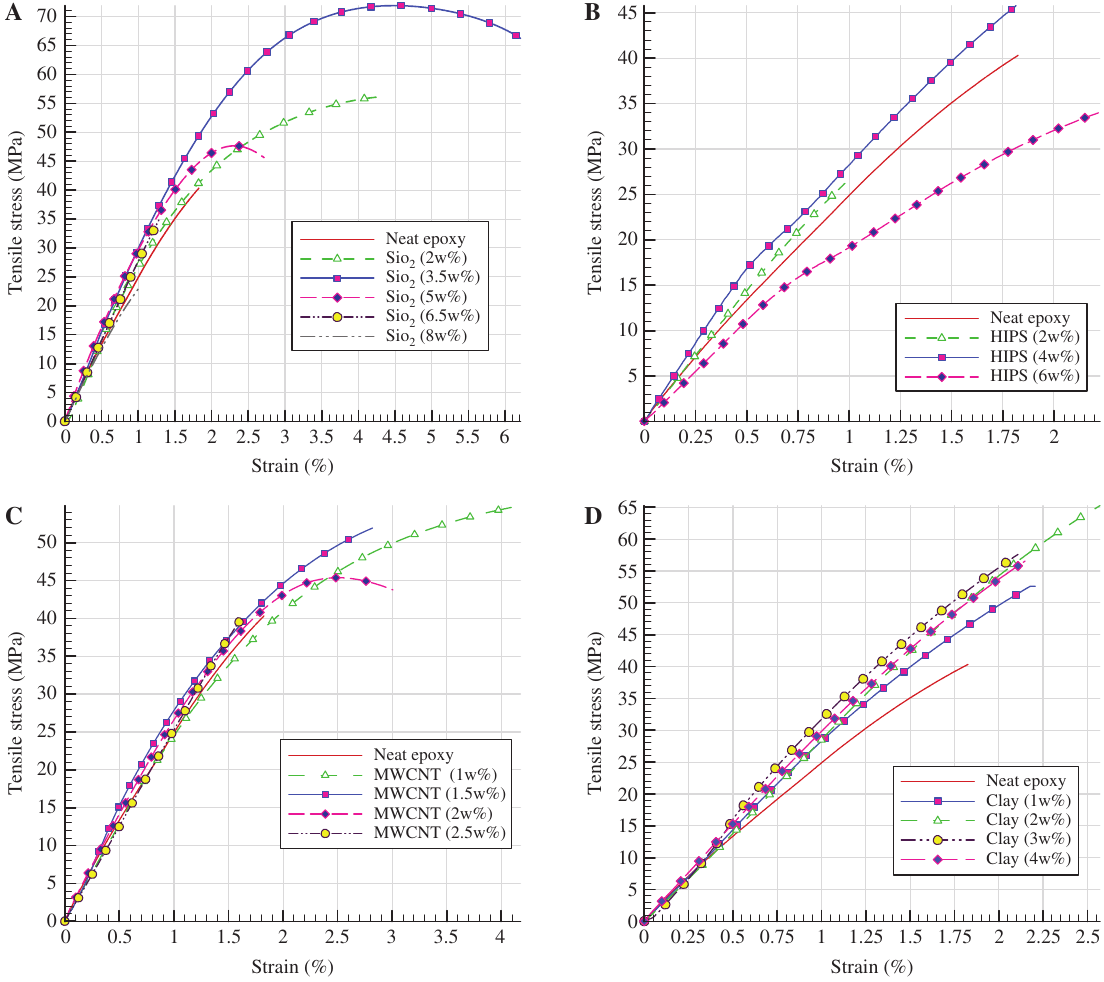
, (B) epoxy/HIPS, (C) epoxy/MWCNT and (D) epoxy/clay. 2